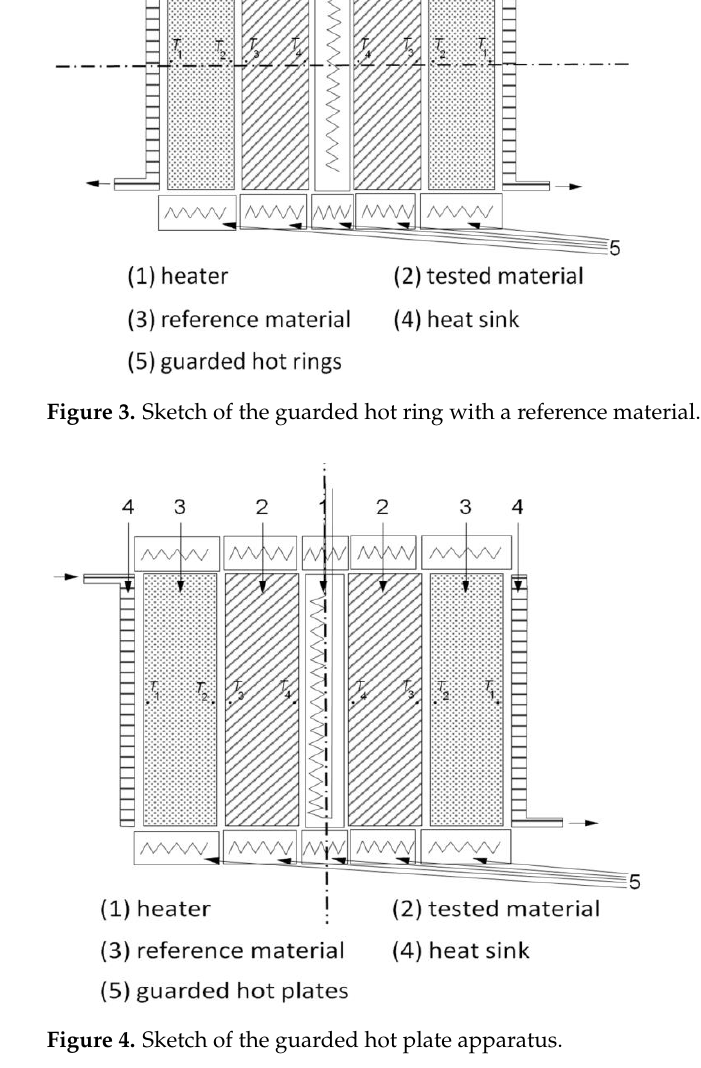
Figure 3. Sketch of the guarded hot ring with a reference material.